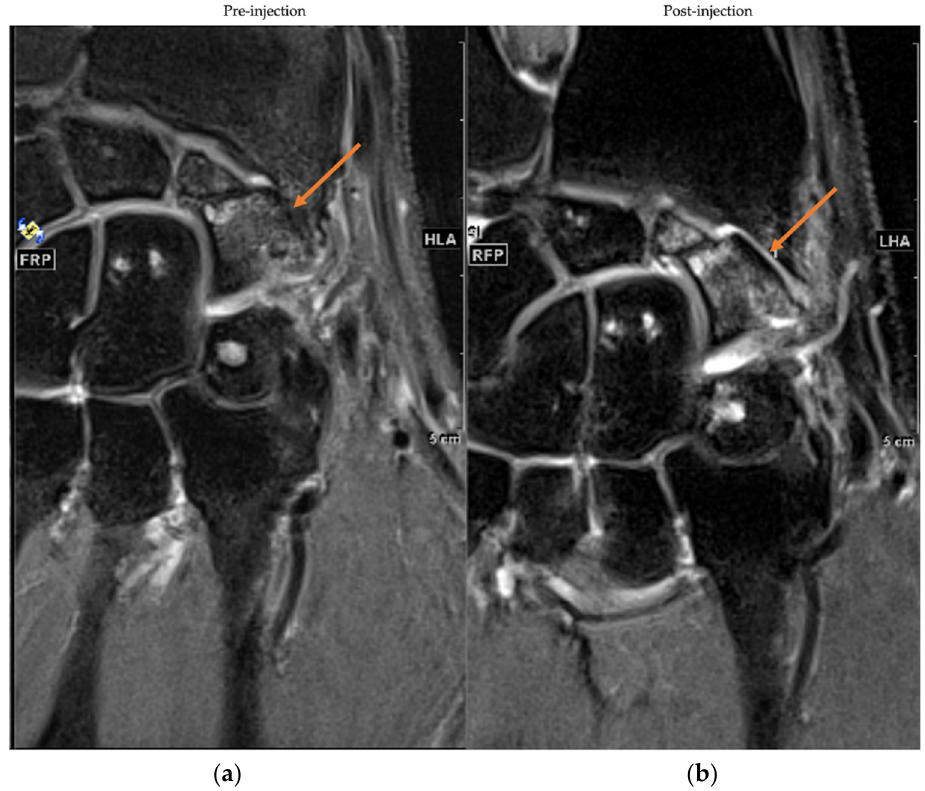
Figure 4. MRIs frontal sections of pre-injection ( a ) and 12 months post-injection ( b ). Cartilage condition was assessed with a 2D proton density turbo spin echo (TSE) with fat saturation sequence. The arrow indicates the location of the joint space of interest.